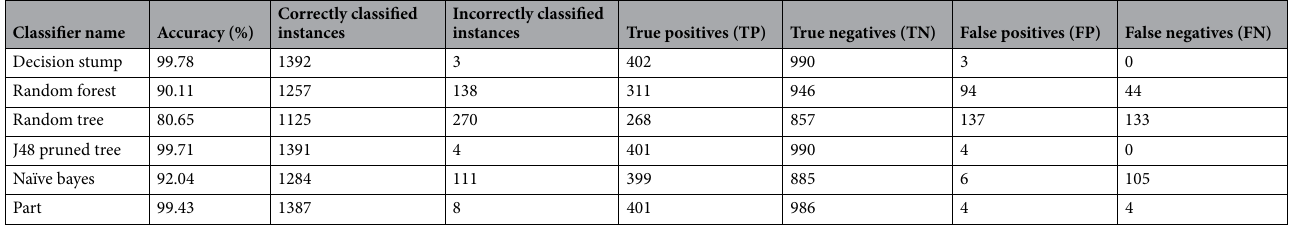
Table 2. Performance comparison of classifiers and their predictive accuracy.